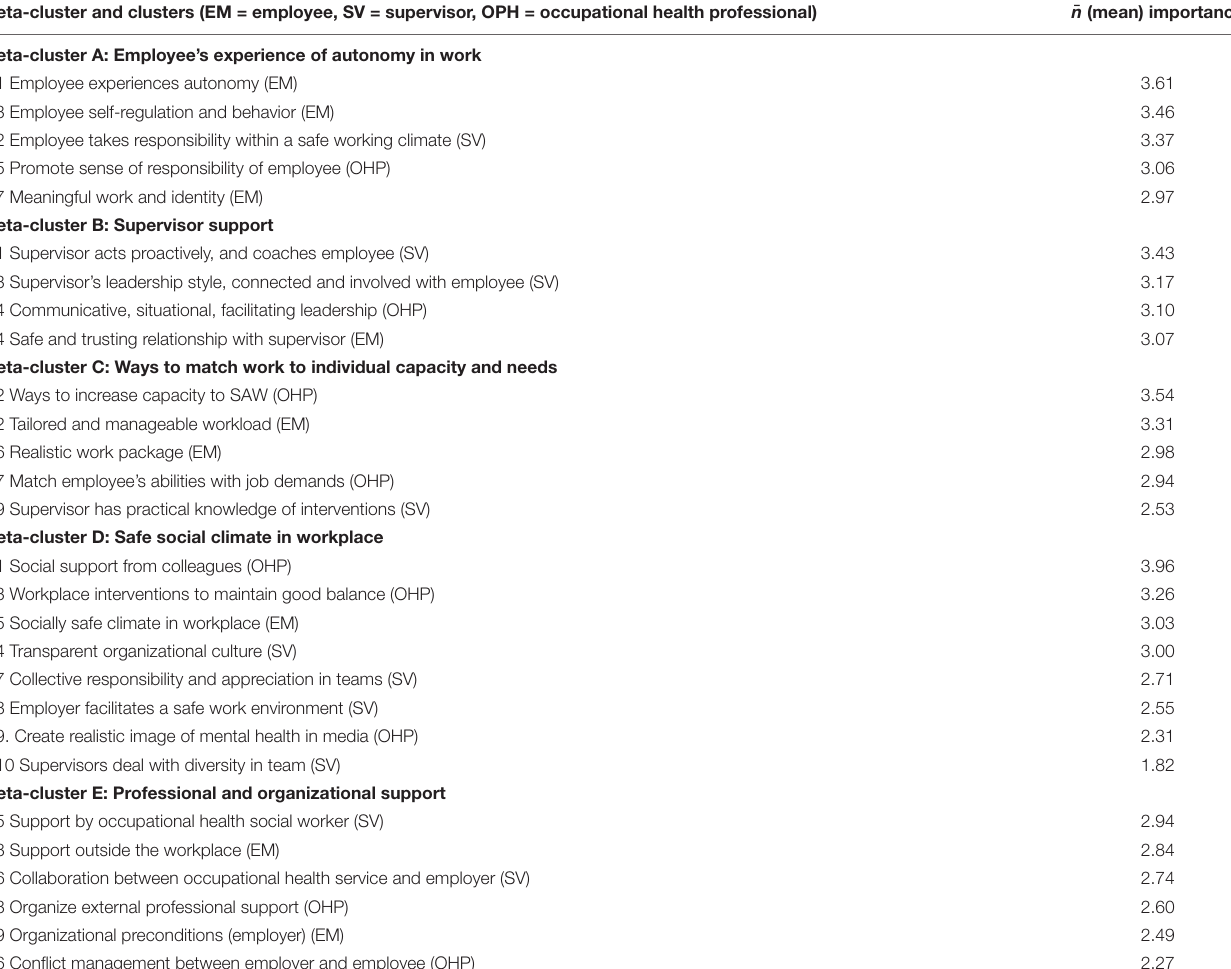
TABLE 3 | Clusters of statements, sorted per meta-cluster, (generated per stakeholder group and given mean importance score per cluster). Meta-cluster and clusters (EM = employee, SV = supervisor, OPH = occupational health